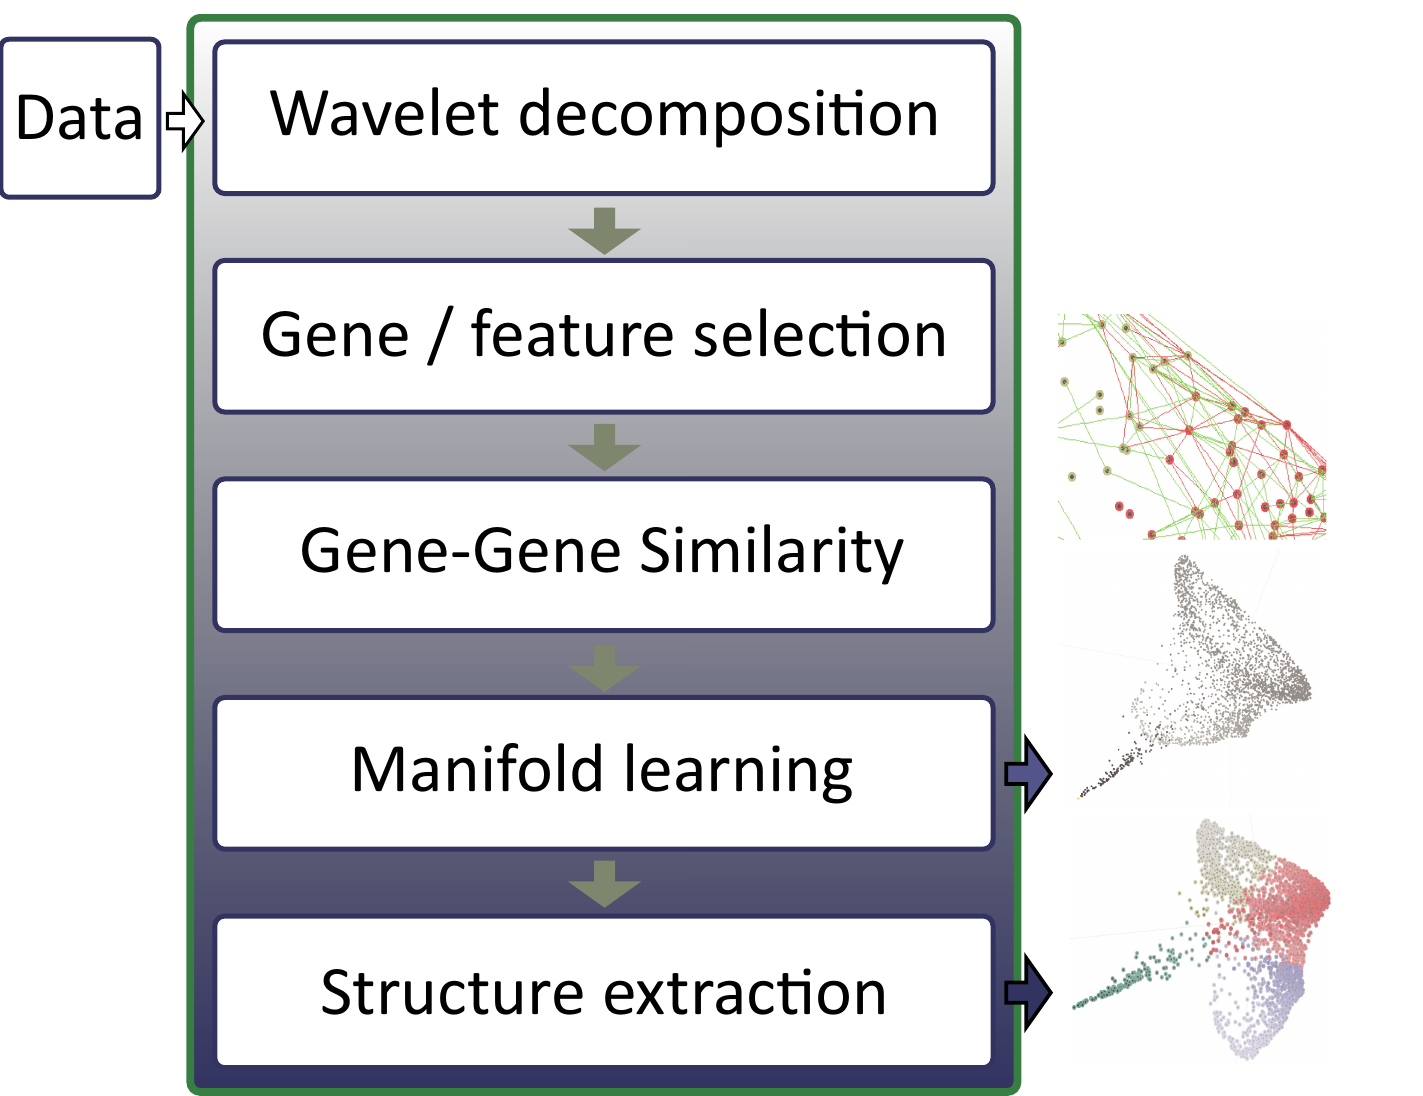
Fig 1. Analytic workflow in AGCT